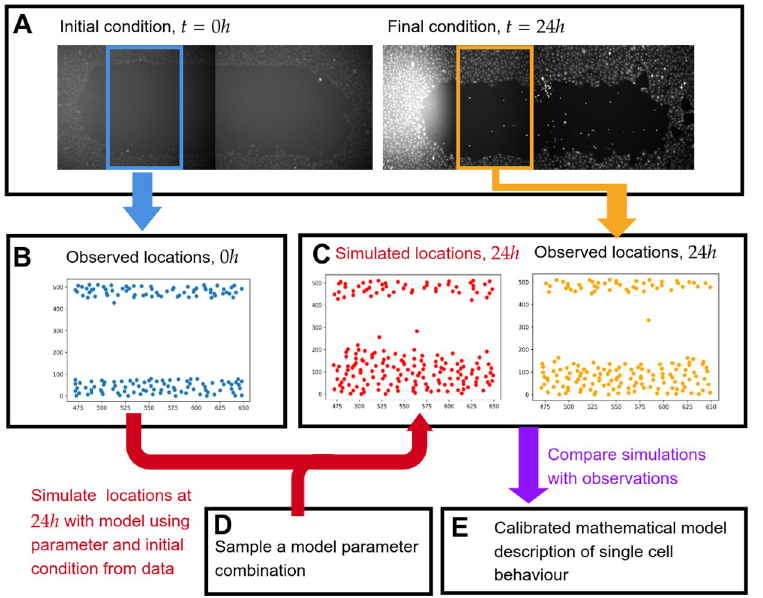
Fig 1. Schematic representation of the process of combining mechanistic modelling and scratch assay data. A: each observation in the data set consists of an initial condition at t = 0 h and a final condition at t = 24 h . B: the field of view of the initial condition is cropped and cell locations are extracted. C: the field of view of the final condition is cropped and cell locations are extracted, as for the initial condition. A mechanistic mathematical model is used to simulate cell locations at t = 24 h using a sampled parameter from box D. E: by simulating many times with different parameter values we can compare which parameters generate simulated data that is mathematically similar to